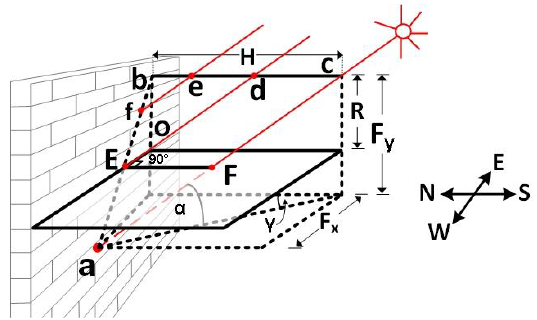
Figure 7. Shadow of a horizontal pole on a horizontal plate.